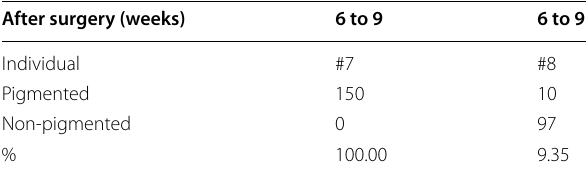
Table 2 Results of the mating analysis: surrogate father of d‑rR strain allografted with wild‑derived strain testis